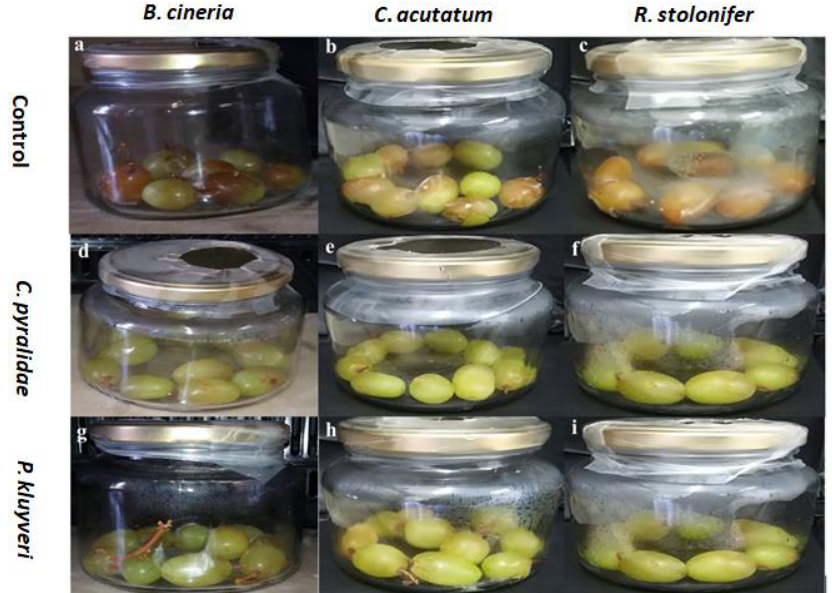
Figure 5. The antagonistic effect of volatiles produced by C. pyralidae against the growth of Botrytis cinerea ( d ), C. acutatum ( e ) and R. stolonifer ( f ), and the antagonistic effect of volatiles produced by Pichia kluyveri on B. cinerea ( g ), C. acutatum ( h ) and R. stolonifer in sealed jars. Negative controls are shown as B. cinerea ( a ), C. acutatum ( b ) and R. stolonifer ( c ). Ten replicates consisting of 10 grape berries per jar were tested. All berries in the negative control jars were spoiled (0% inhibition ± 0.00) while the treated jars were not spoiled (100% inhibition ± 0.00).